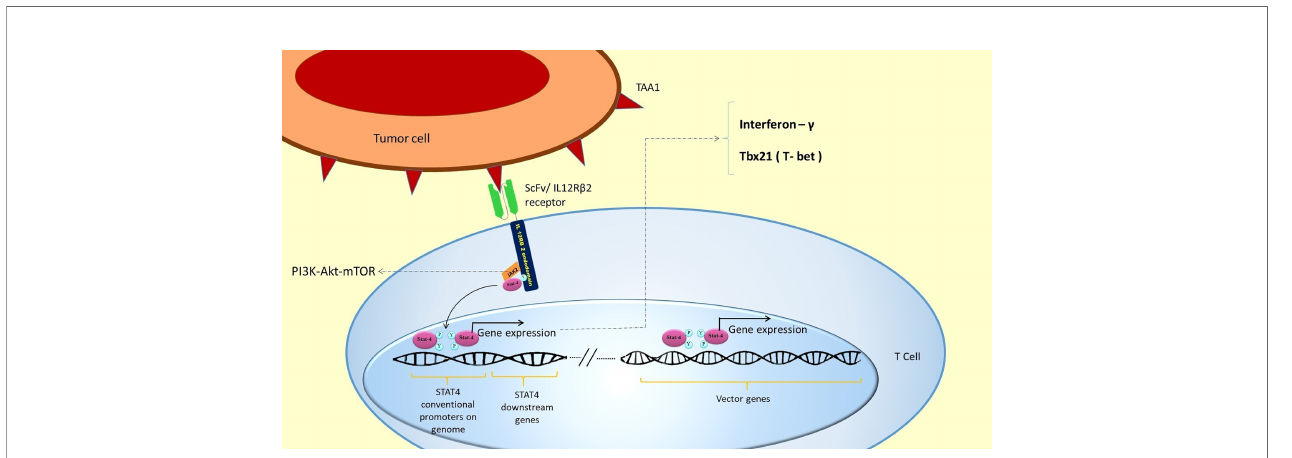
FIGURE 6 | STAT4 activation and the expression of its downstream genes in the genome: TAA1 recognition by ScFv/IL-12R b receptor leads to STAT4 activation. Activated STAT4 binds to its conventional promoters in the T cell genome. This binding automatically expresses favorable genes in addition to expressing the inserted vector genes. STAT 4 conventional genes include IFN- g and Tbx21 (T-bet), which induces TH1 phenotype and cytotoxicity in T cells (39). This expression could potentiate T cells ’ proliferation and survival and attenuate in fl ammatory processes in the tumor area. JAK2 also activates PI3K/AKT/mTOR cell survival signaling pathway, which plays a pivotal role in T cell proliferation, survival, and protein